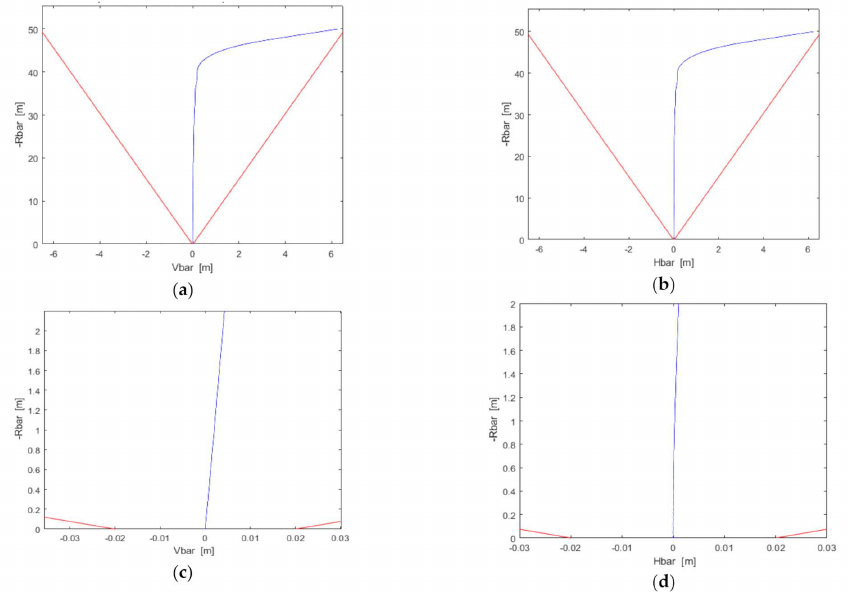
Figure 4. 2D trajectory in ( a ) H-bar-R-bar plane and ( b ) V-bar-R-bar plane, and the detail of the last